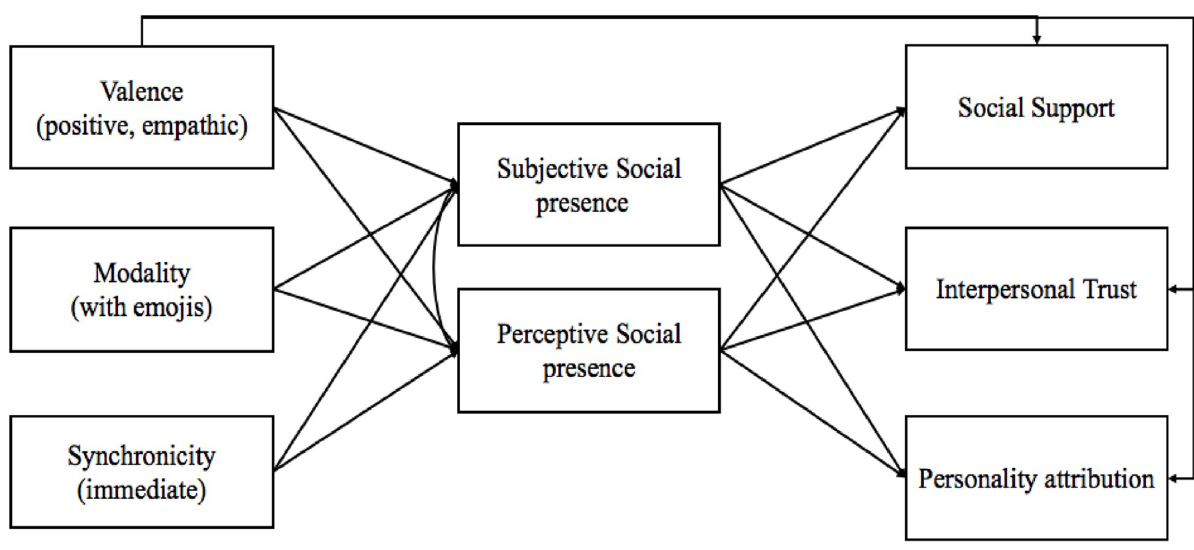
Fig 1. Theoretical model. All relationships are hypothesized to be